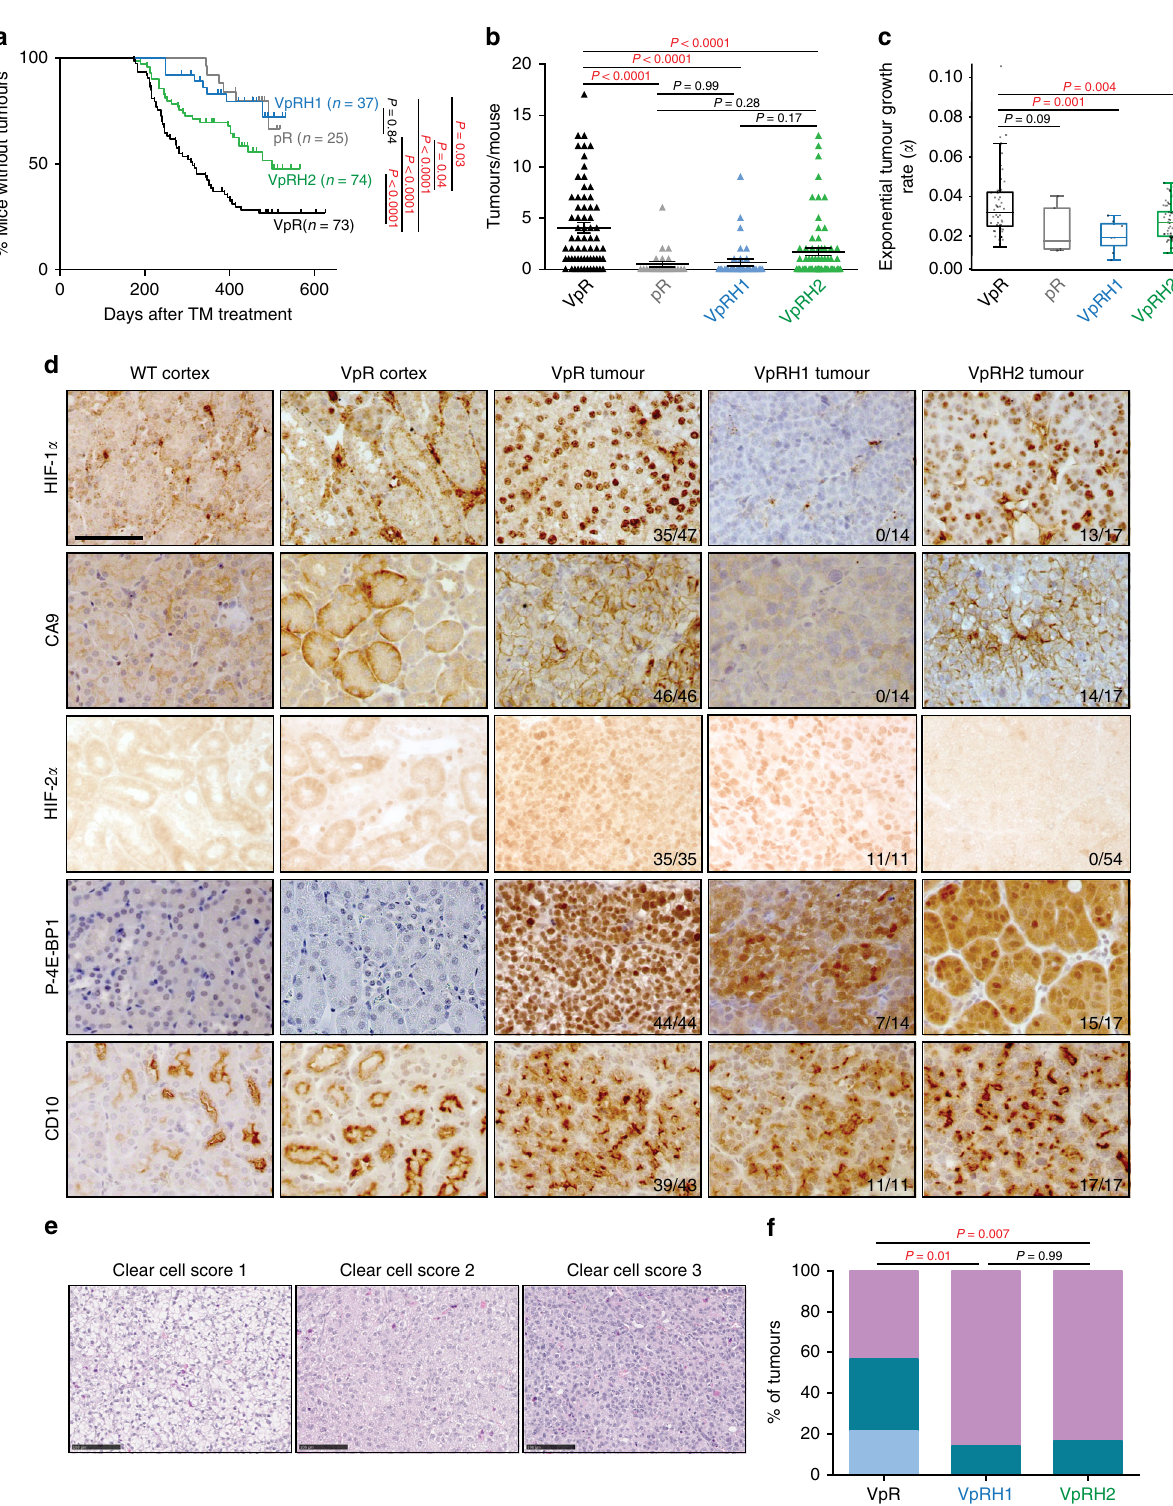
normalised to the average of the three non- fl oxed exons were reduced for Vhl , Trp53, and Rb1 compared to WT cortex and for Hif1a and Hif2a when compared to WT cortex or to mouse genotypes that did not harbour the fl oxed allele (Supplementary Fig. 2b). Residual fl oxed exons (~10 – 15% allelic burden) in the genomic DNA of tumours likely re fl ect